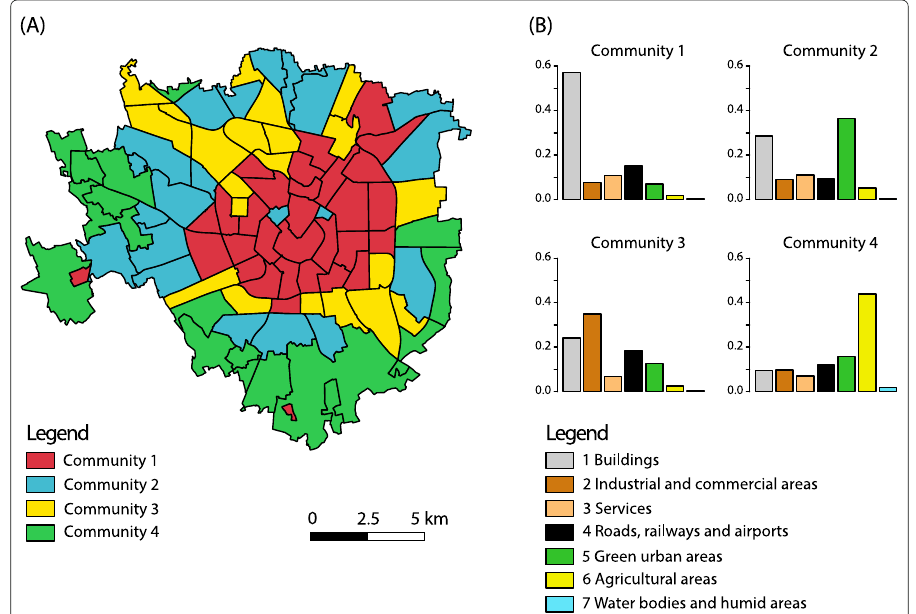
Fig. 3 Community detection based on land uses. a Results of the community detection based on modularity optimization performed on a complete undirected network of the similarity between the land uses in